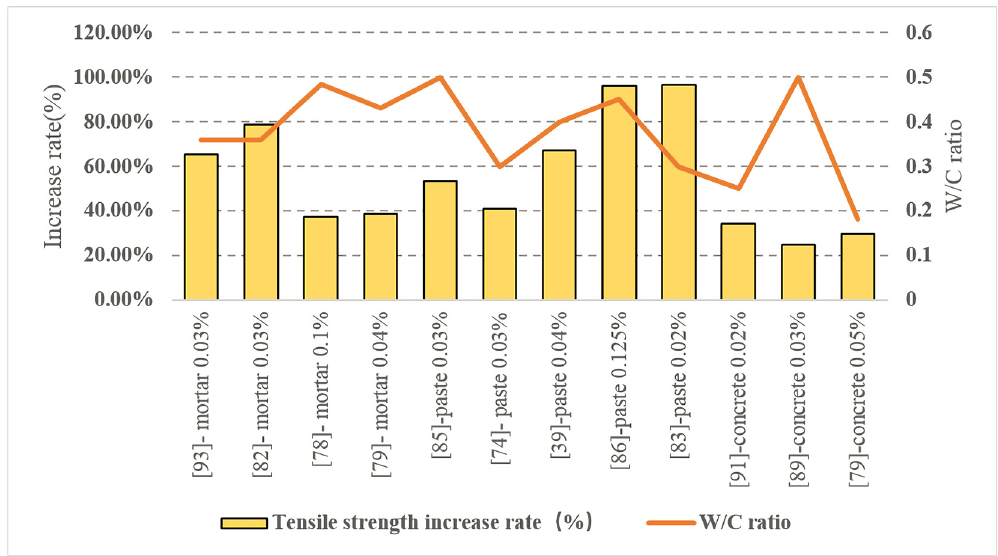
Figure 12: Tensile strength enhancement of GO reinforced cement composite specimens.